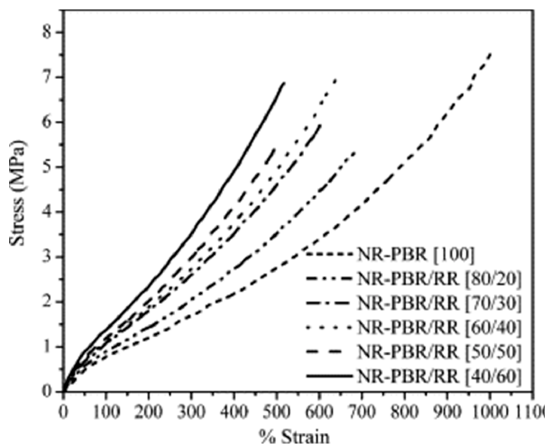
Figure 25. Tensile fractured surface of the compounds of Figure 24: ( a ) NR-PBR (100), ( b ) NR- PBR/RTR (80/20), ( c ) NR-PBR/RTR (60/40) and ( d ) NR-PBR/RTR (40/60) (reproduced with permission from [121]). However, Sreeja et al. [116,117] reported an increasing trend of the tensile strength with RTR incorporation into NBR and SBR matrices in contrast to the decreasing trend of the tensile strength of NR/RTR compounds [112]. The tensile strength of NBR and SBR samples increased from 1.8 and 1.9 to 6.3 and 5.1 MPa, respectively, with the addition of 80 parts RTR [116,117]. However, increasing the RTR loading led to a tensile strength drop for NR/RTR compounds indicating a higher